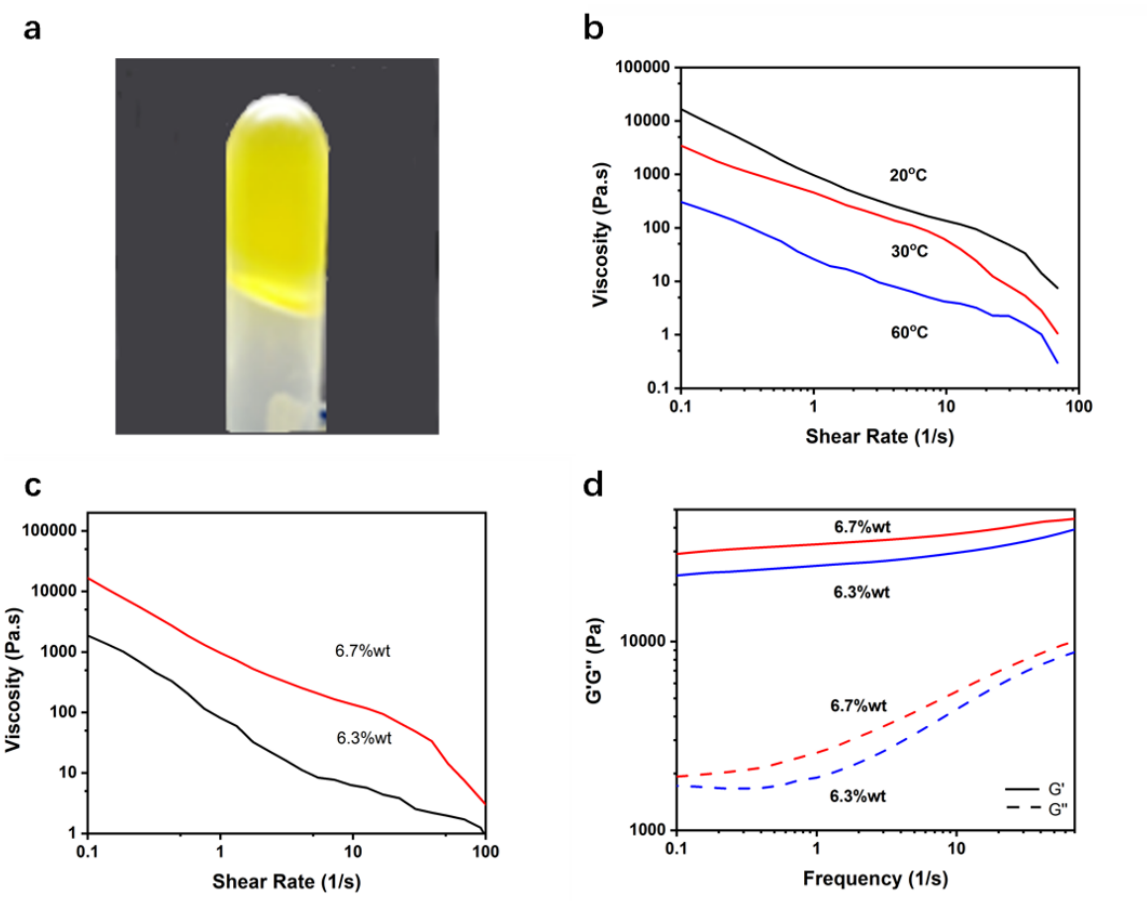
Figure 2: The rheological properties of the viscous cellulose solutions: (a) optical picture of the 6.7 wt% cellulose solution; (b) the viscosity of the 6.7 wt% cellulose solution as a function of shear rate under different temperatures; (c) the viscosity of the cellulose solutions with different concentrations (6.3 wt% and 6.7 wt%) as a function of shear rate; (d) the storage modulus (G ′ , the hard line) and the loss modulus (G ′′ , the dotted line) of the cellulose solutions with different concentrations (6.3 wt% and 6.7 wt%) under room